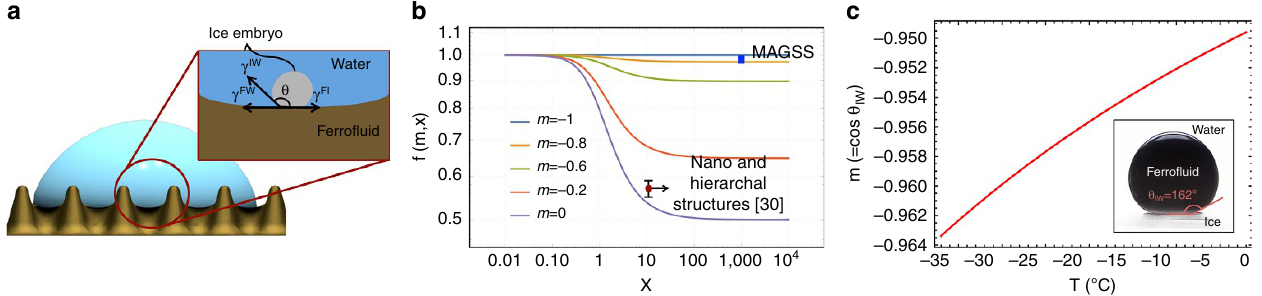
Figure 4 | Mechanism of exceptional icephobicity in MAGSS. Physics of the exceptional icephobicity in MAGSS is discussed. ( a ) Schematic of water droplet on MAGSS; an ice embryo at the water–MAGSS interface along with involved interfacial energies are shown. ( b ) The geometrical function of heterogeneous ice nucleation, f ( m , x ) is plotted as a function of m and x . The f value of unity corresponds to the homogeneous nucleation limit and smaller f functions favours heterogenous ice nucleation. The m value for MAGSS and other state-of-the-art hierarchical structures are shown. ( c ) The value of m for MAGSS is measured as a function of temperature. The contact angle of a ferrofluid droplet on ice in a water environment is used to determine the value of m (inset of c ). The m value of MAGSS is less than (cid:2) 0.95, suggesting that MAGSS raises the energy barrier for ice nucleation to close to homogenous nucleation